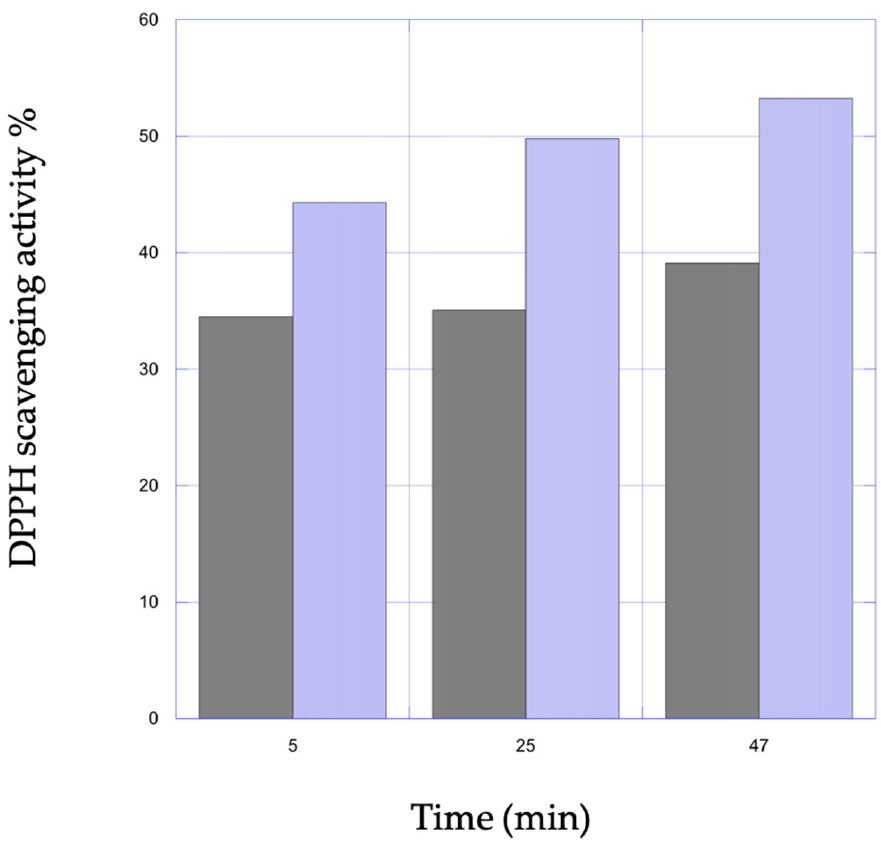
Figure 6. Representation of percent scavenging activity on DPPH as a function of time of VitE 0.1 ( black ) and VitE 1 ( light blue ) scaffolds.